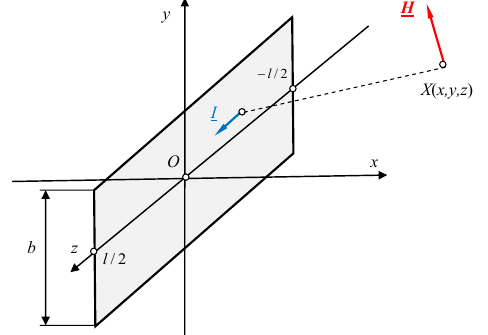
Fig. 1. Ribbon busbar of finite